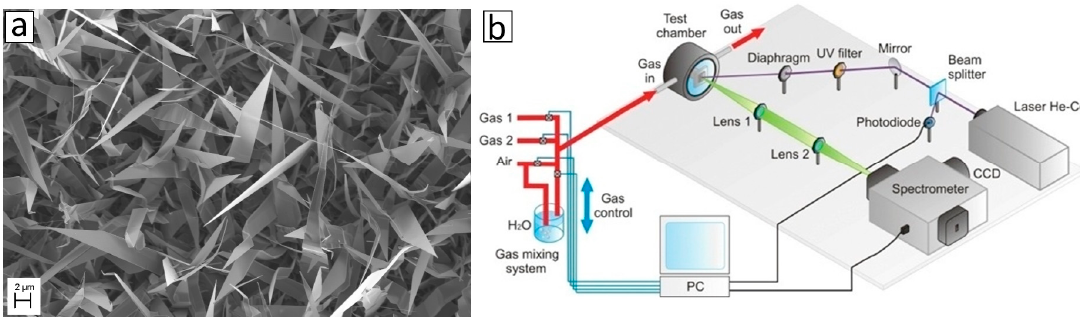
Figure 9. ( a ) SEM image of ZnO NWs; ( b ) Photoluminescence (PL) spectrum is acquired perpendicular to the sample surface by a single spectrograph and a CCD camera. The excitation wavelength is 325 nm (He-Cd laser). A sealed chamber is used for gas tests.